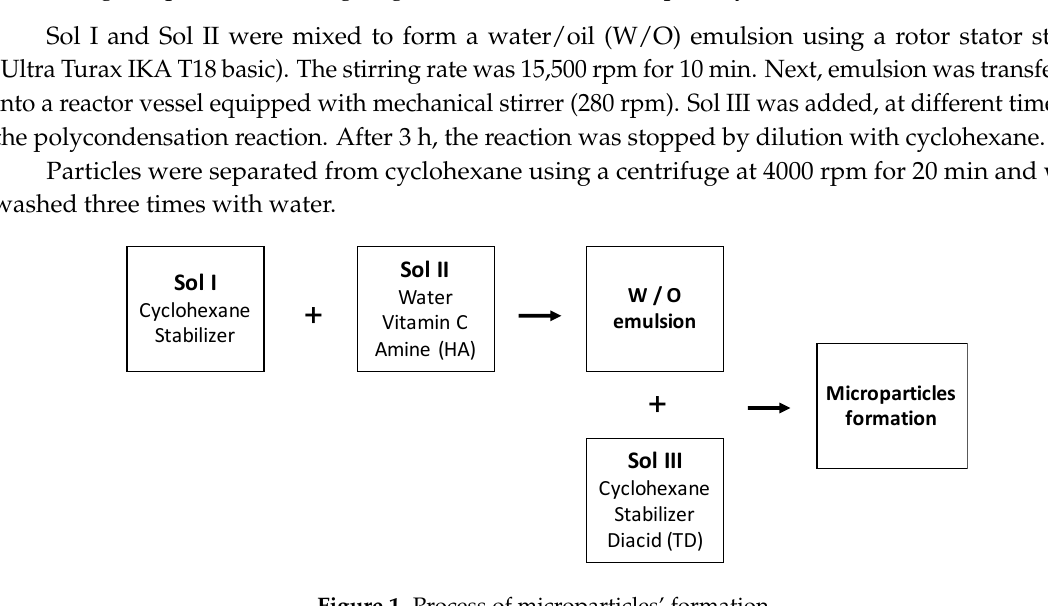
Figure 1. Process of microparticles’ formation.